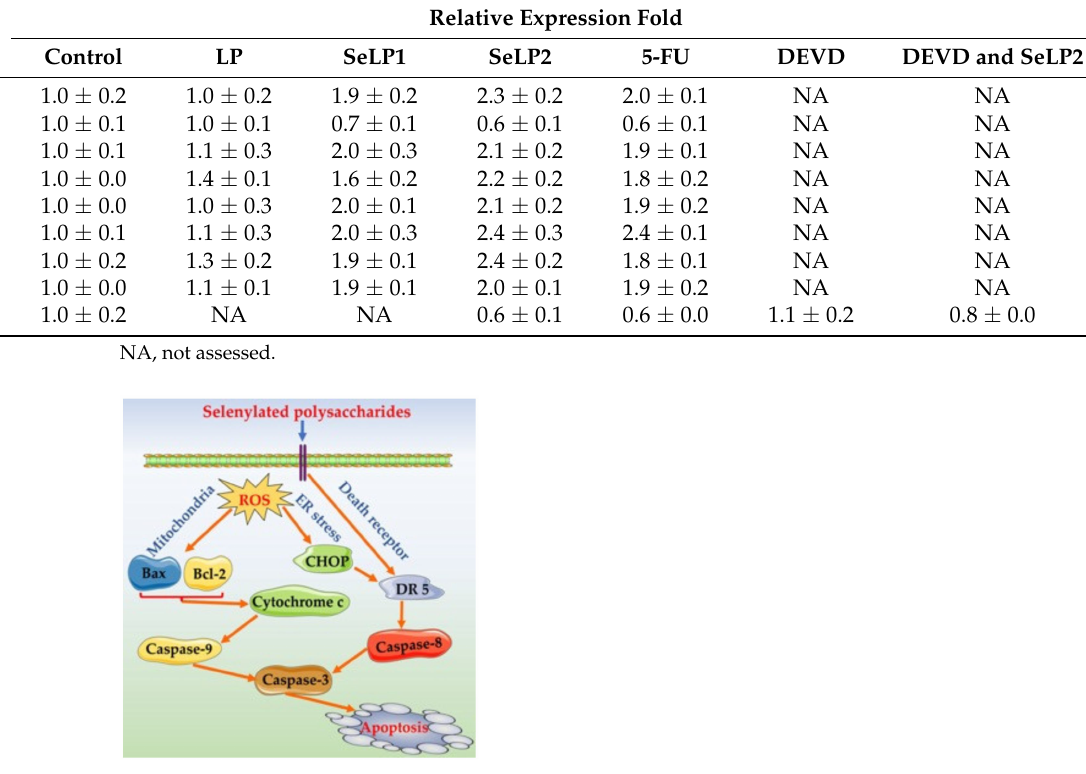
Figure 6. Western blot assay of the apoptosis-related proteins in HT-29 cells treated without or with 5-FU, longan polysaccharides (LP), and two selenylated polysaccharides (SeLP1 and SeLP2) for 48 h ( A ), or the caspase-3 in HT-29 cells treated with a caspase-3 inhibitor DEVD for 48 h ( B ). “+” indicates HT-29 cells were treated with this sample, “ − “ indicates HT-29 cells were not treated with this sample. Table 4. Expression changes of the apoptosis-related proteins in HT-29 cells exposed to longan polysaccharides (LP), two selenylated polysaccharides (SeLP1 and SeLP2), inhibitor DEVA, or DEVA plus SeLP2.